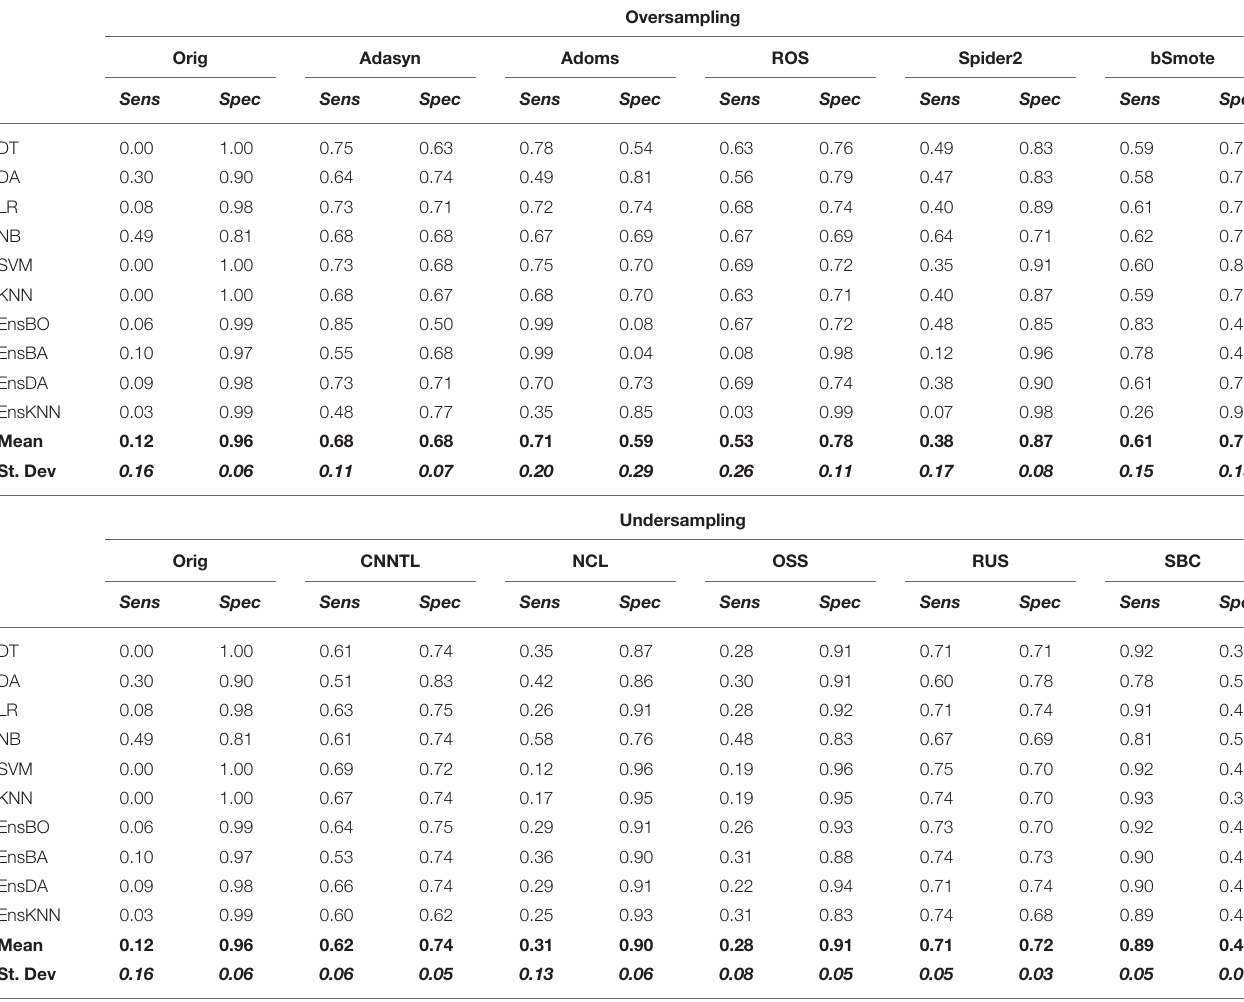
TABLE 6 | The Sensitivity (Sens) and Specificity (Spec) values for oversampling and undersampling techniques.